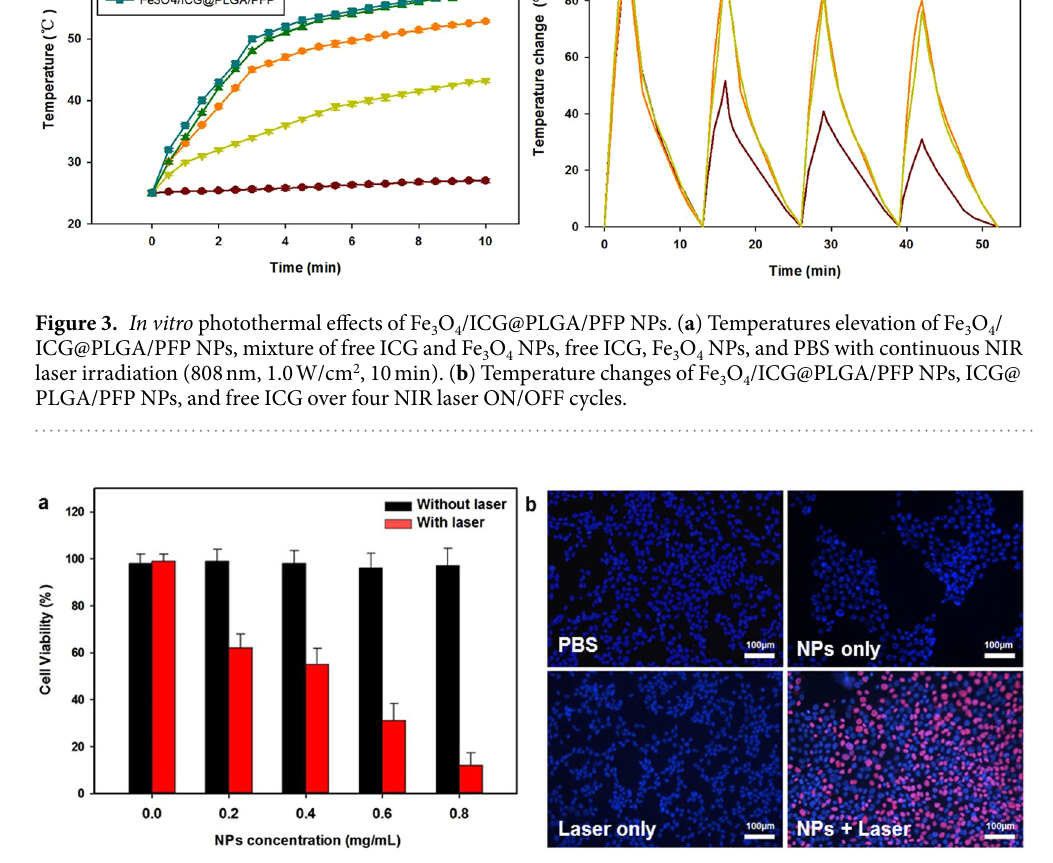
Figure 4. In vitro cytotoxicity experiments. ( a ) Relative viability of MCF-7 cells incubated with different concentrations of Fe 3 O 4 /ICG@PLGA/PFP NPs under laser irradiation (808 nm, 1 W/cm 2 , 5 min). ( b ) Fluorescence images of Hoechst 33342/PI co-stained MCF-7 cells incubated with Fe 3 O 4 /ICG@PLGA/PFP NPs (0.5 mg/mL) and exposed to the 808 nm laser irradiation (1 W/cm 2 , 5 min). Live and dead cells were stained with Hoechst 33342 (blue color) and PI (red color),